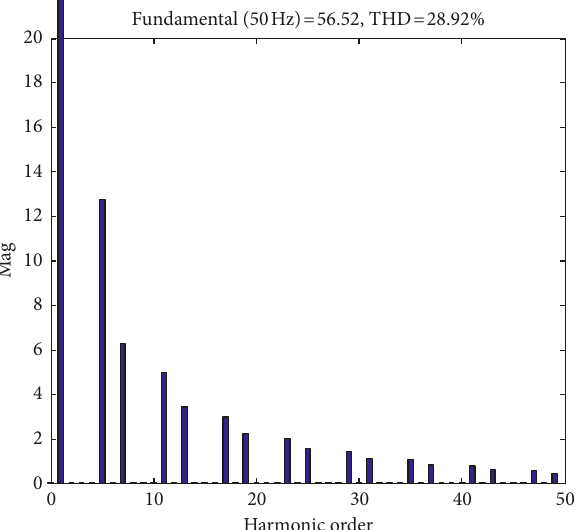
Figure 12: FFT analysis of nonlinear load current.